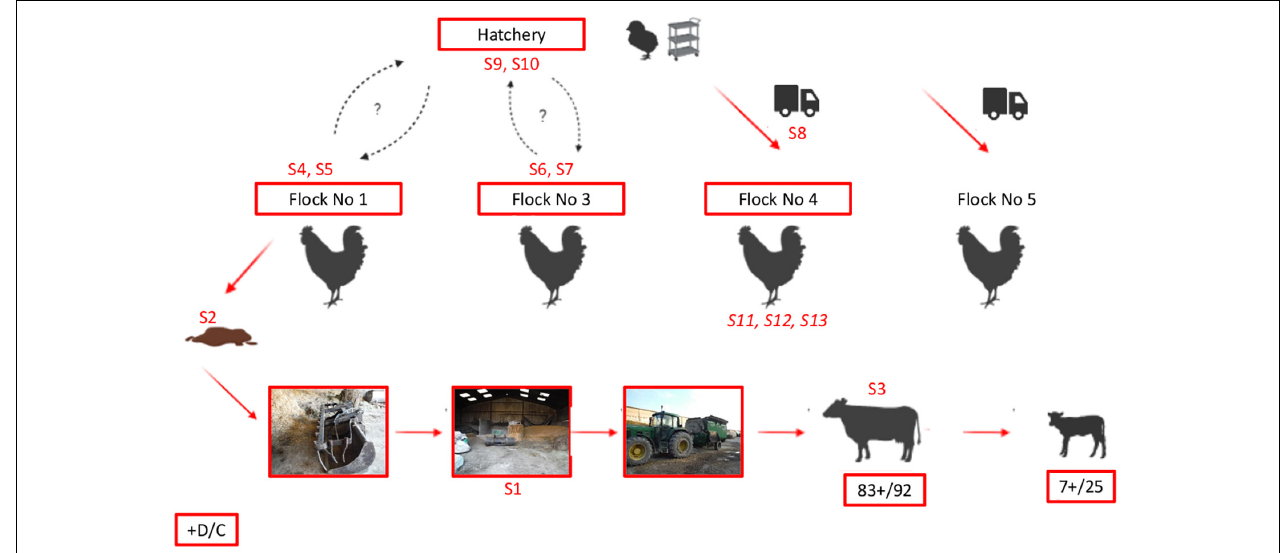
FIGURE 3 | Diagram summarizing the likely relationships between the broilers, cattle, and hatchery based on investigations and results obtained in this study. Samples collected during the study and positive for C. botulinum type D/C are shown in red. References of samples tested using MLVA ( Figure 2 ) are mentioned in the diagram. Note that samples S11–S13 are shown in italics in contrast to the other samples (S1–S10), because they showed a different MLVA profile ( Figure 2 ). “ + D/C”: sample positive for bont D/C using PCR are surrounded in Red. Detailed results of samples collected and analyzed in our study are given in Table 1 (initial investigations during cattle botulism outbreak), Table 2 (monitoring of successive broiler flocks), and Table 3 (investigations in the hatchery that delivers chicks to the